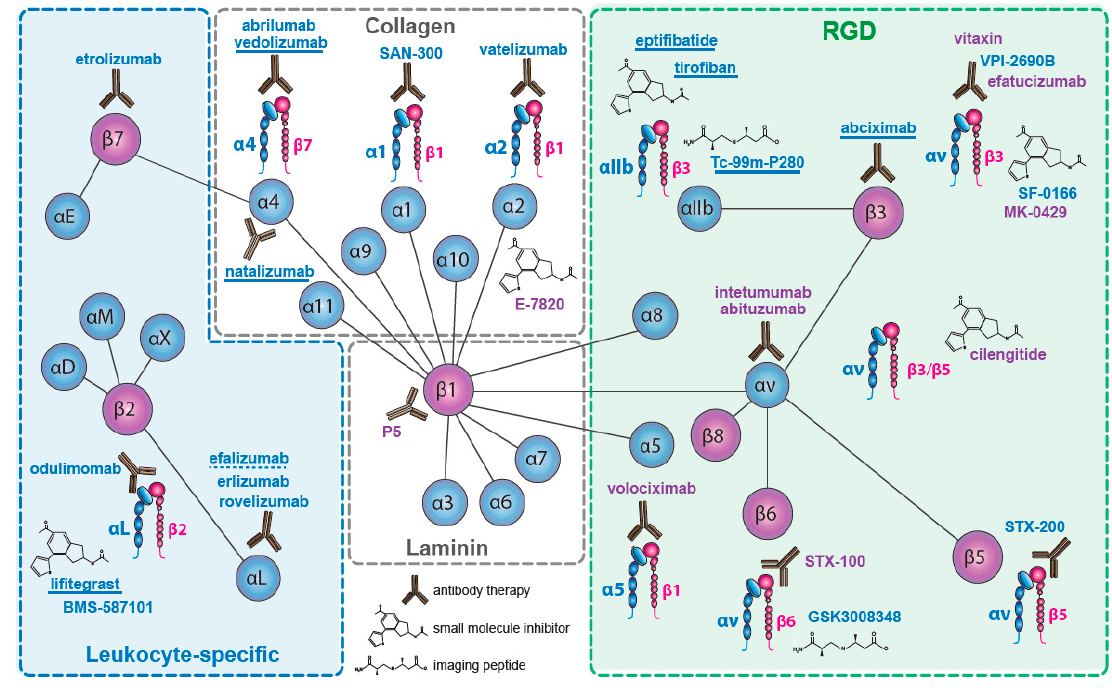
Figure 1. Integrins targeted in late stage clinical trials. The chains or heterodimers targeted, together with symbols indicating the type of drug used as mentioned in text are shown. Drugs named in violet have been used in cancer trials. Non-cancer drugs are named in blue. Marketed drugs are underlined; withdrawn drug indicated with broken underline.